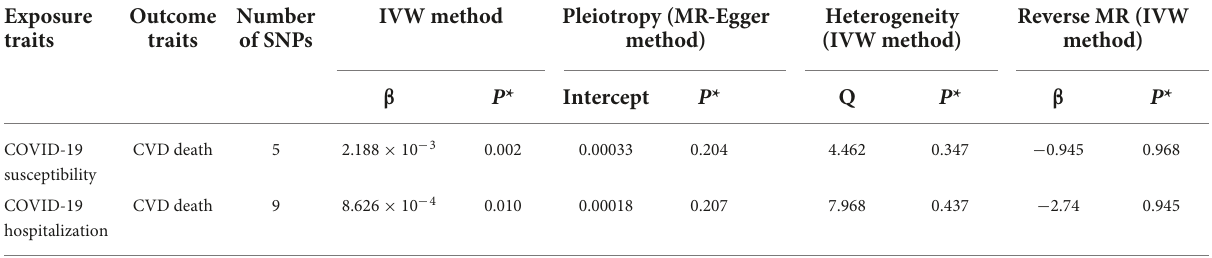
TABLE 1 Univariable MR results of the effect of genetically predicted COVID-19 traits on CVD death risk. Exposure traits